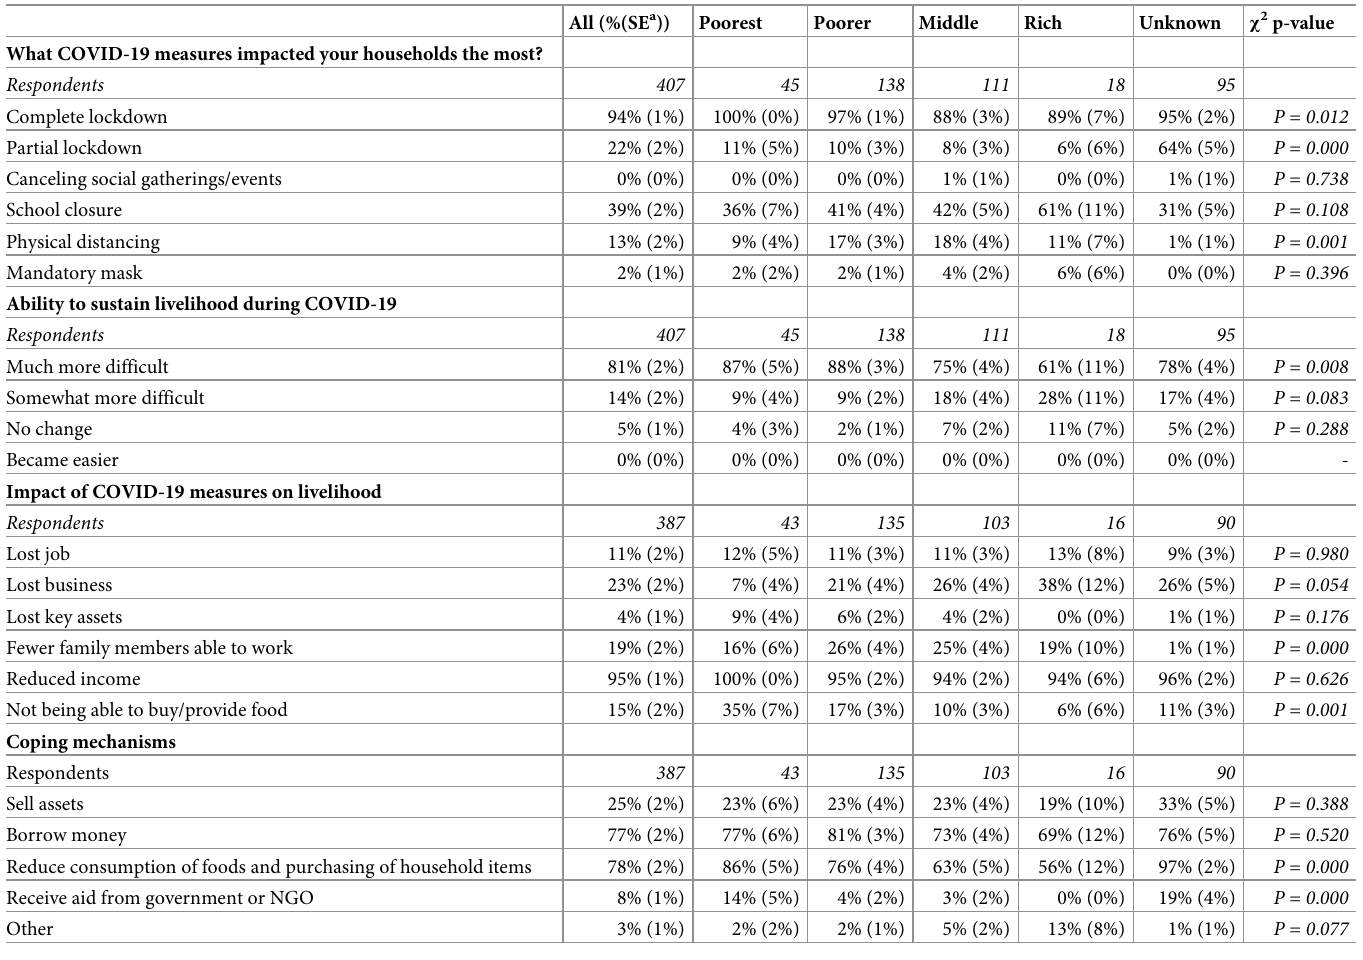
Table 3. Impact of COVID-19 preventive measures on livelihoods, and coping